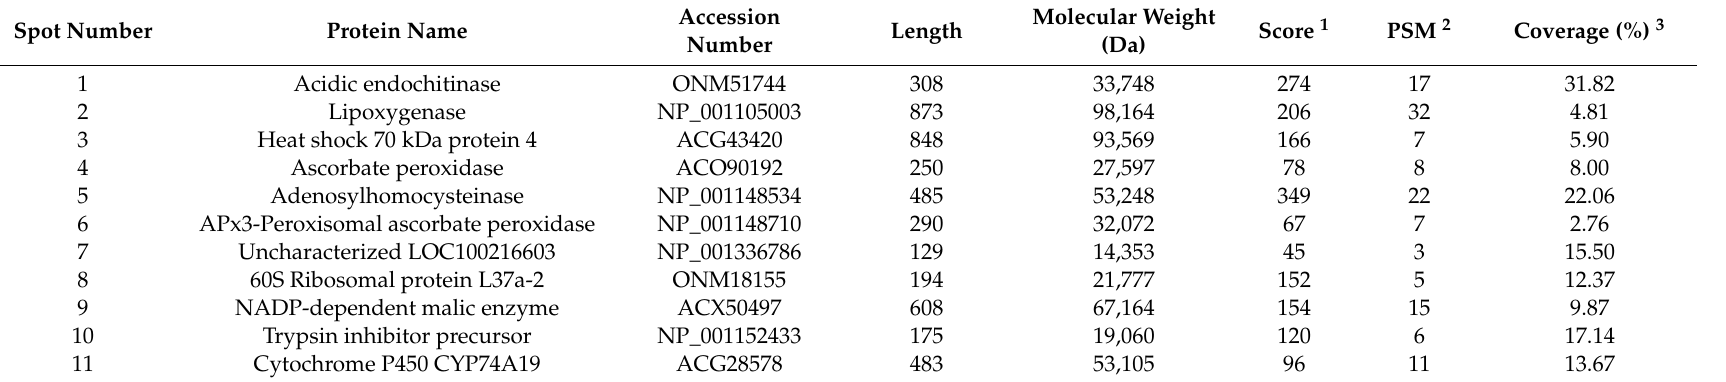
Table 1. CSE proteins identified by LC-MS /